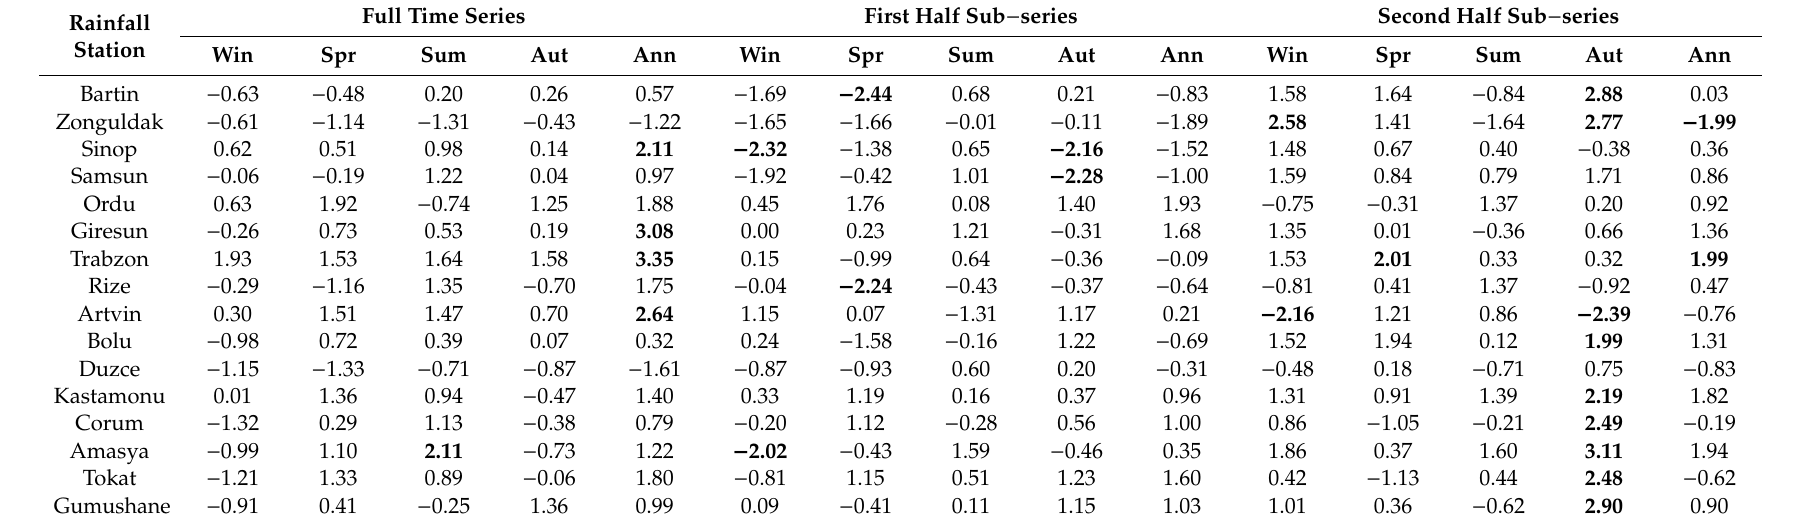
Table 2. Statistical results of trend analysis for seasonal and annual rainfall using the CSD